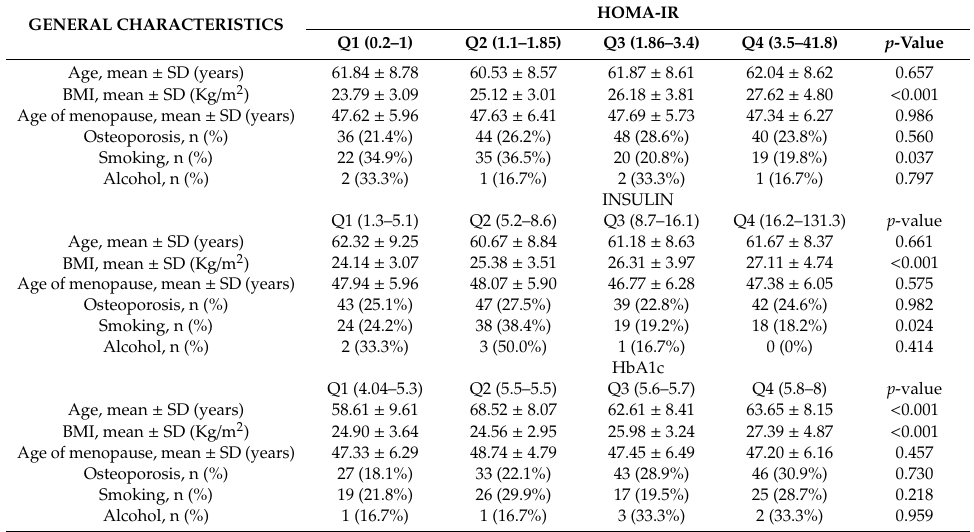
Table 2. General characteristics of the study population stratified by quartiles of HOMA-IR, insulin and HbA1c. GENERAL CHARACTERISTICS